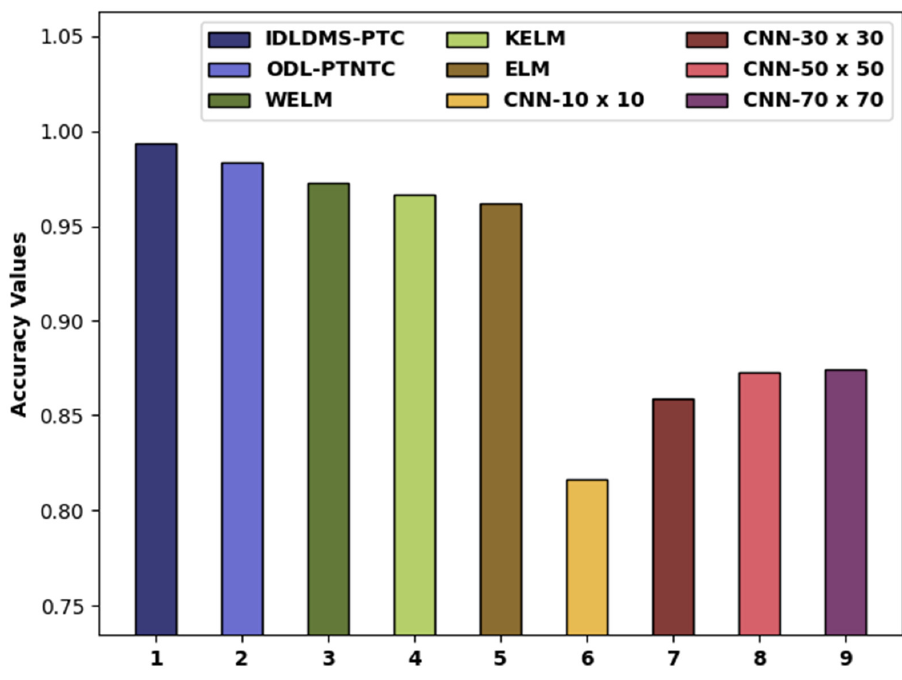
Figure 11. Acc y analysis of IDLDMS-PTC technique compared with recent Figure 11.   analysis of IDLDMS-PTC technique compared with recent approaches.